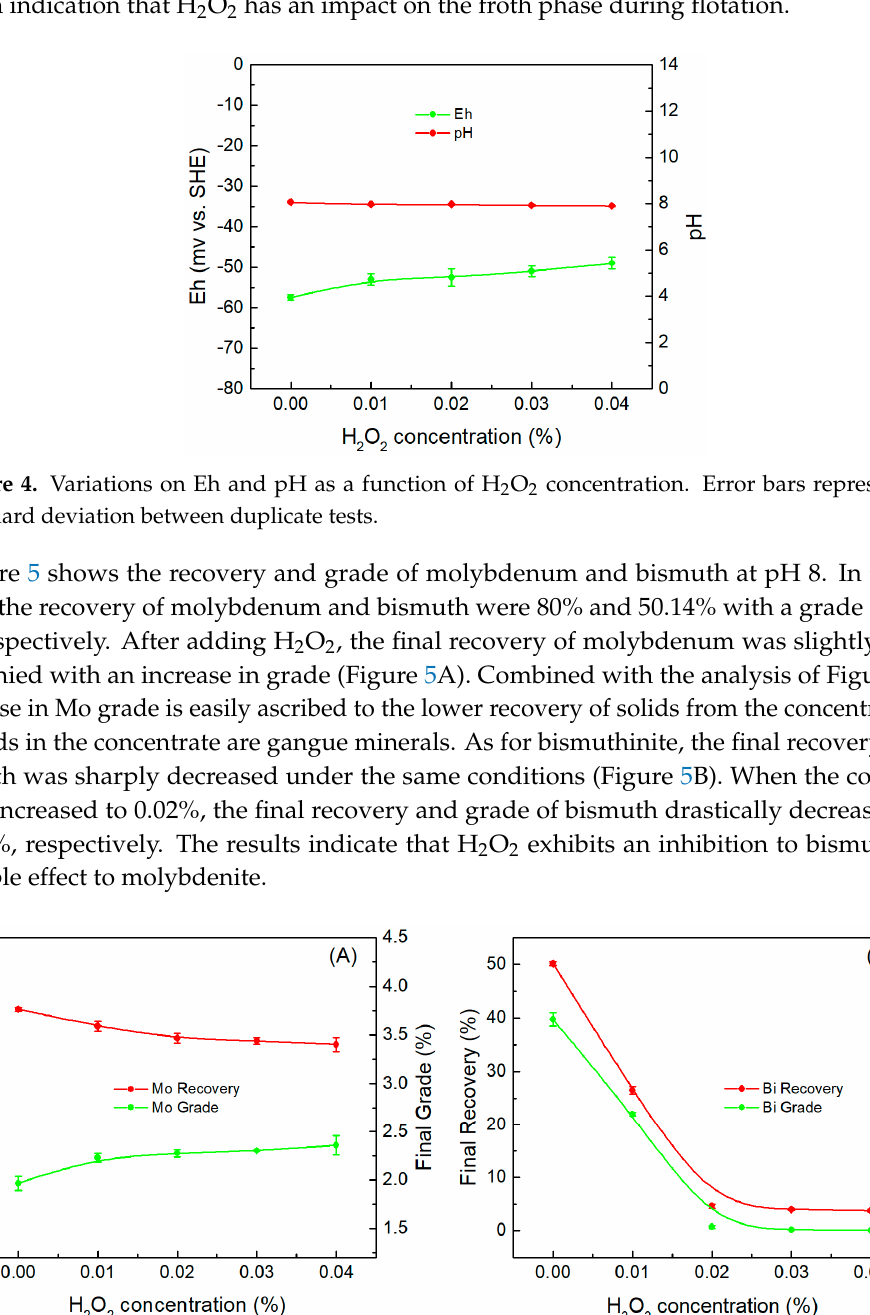
Figure 5. Final recovery and grade as a function of H 2 O 2 concentration: ( A ) molybdenum, ( B ) bismuth. Error bars represent the standard deviation between duplicate tests.